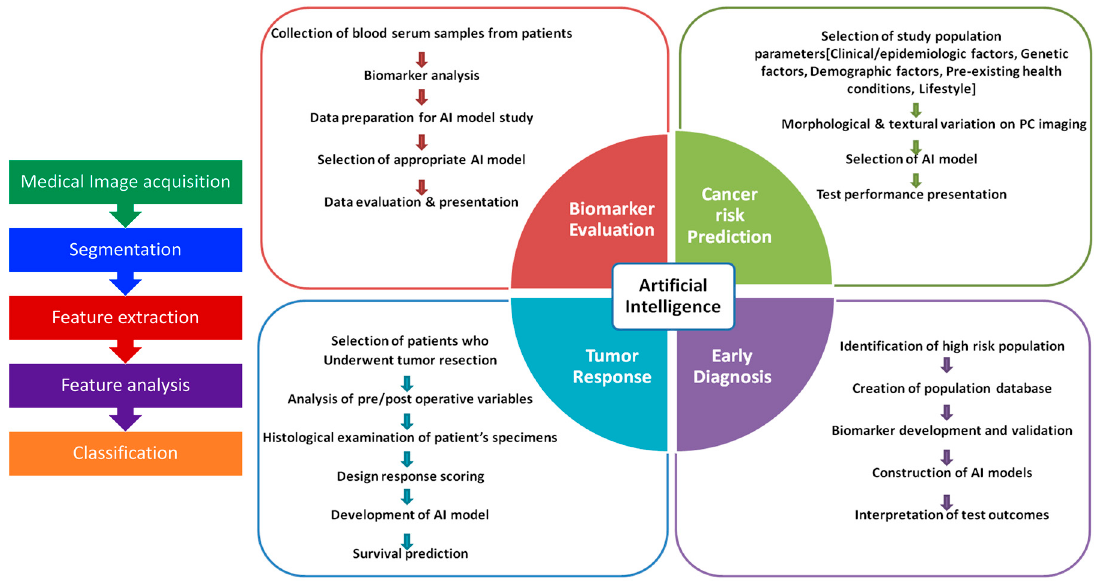
Figure 1. Work-flow of the stages during the training of the ML models for the diagnosis of cancer lesions.